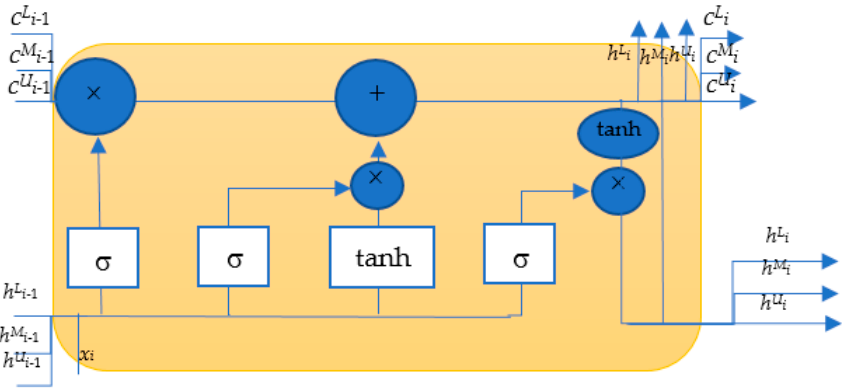
Figure 2. A construction diagram of the fuzzy LSTM prediction model.